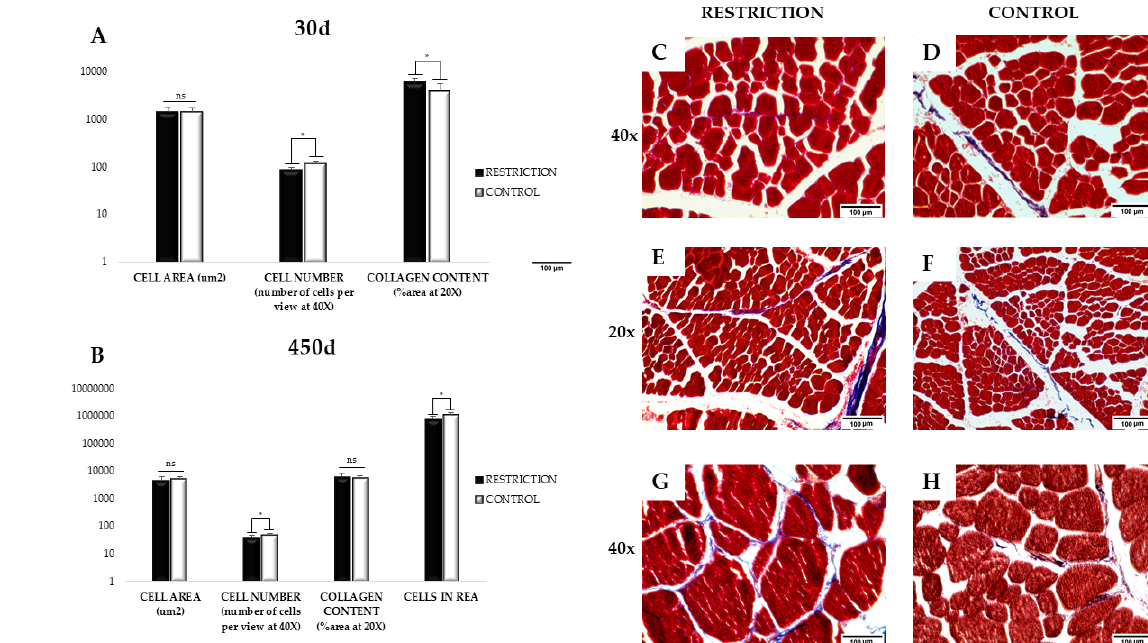
Figure 1. Cell area (um 2 ), cell number (number/view), collagen content (%area) of the skeletal muscle of the offspring at 30d and 450d of age resulting from maternal protein restriction and control group ( A , B ), and number of muscle cells in rib eye area (REA) measured at 450d ( B ). Bars represent means ± SEM. Histological images from the skeletal muscle of the offspring from restriction ( C , E ) and control ( D , F ) group at 30d. Histological images from the skeletal muscle of the offspring from restriction ( G ) and control ( H ) group at 450d. To combine different measurement units into the graph, the data were transformed into